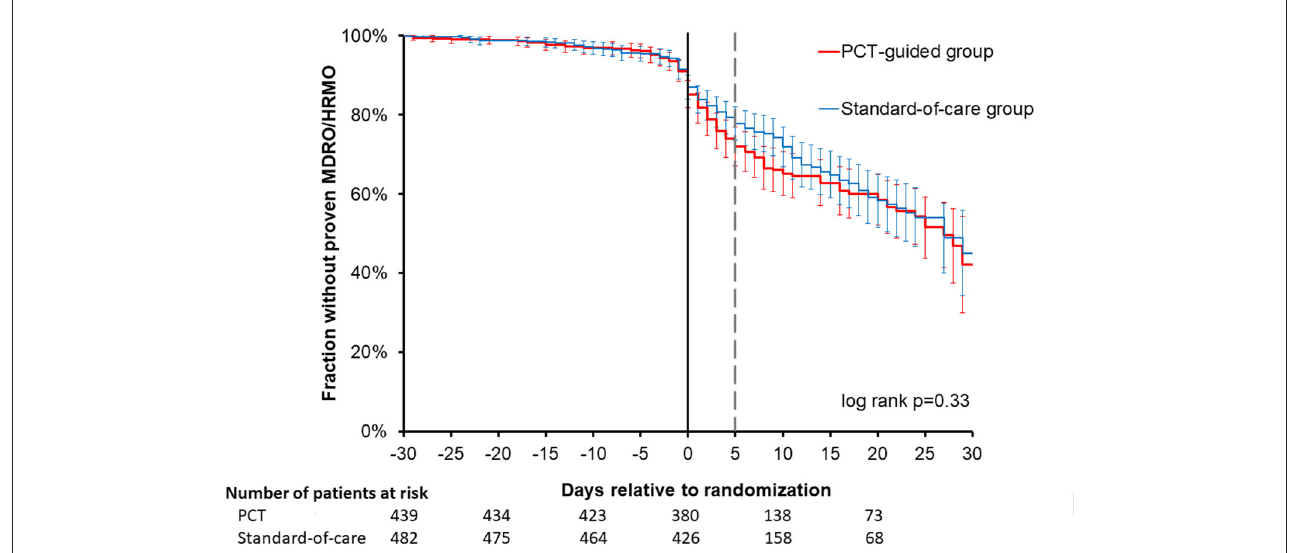
FIGURE1 Time course of resistance development in the two trial arms. For all patients studied, the first occurrence of a multi-drug resistant (MDR) or highly resistant microorganism (HRMO) was compared between the procalcitonin (PCT) and standard-of-care groups from − 30 to + 30 days relative to randomization. No significant difference was observed between these two time courses. The actuarial cumulative percentages with 95% confidence intervals were plotted for the first occurrence of MDR/HRMO with the Kaplan-Meier method and compared for the PCT and control groups. The thinner, dashed vertical gray line represents the demarcation between baseline period ( − 30 days through + 5 days) and the subsequent period ( + 5 days through + 30 days) that we